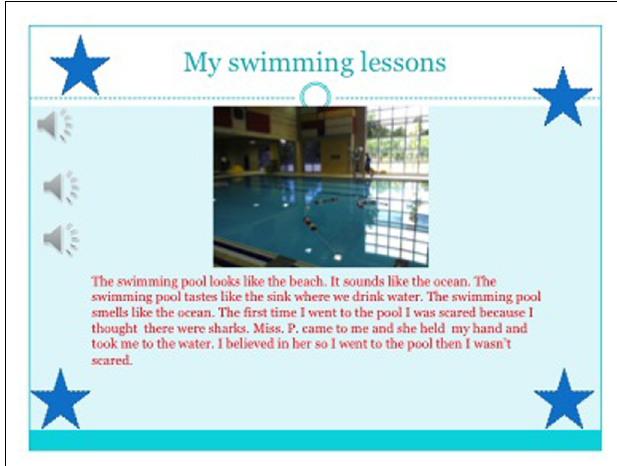
FIGURE 4 |A slide from Fatu’s PowerPoint presentation.